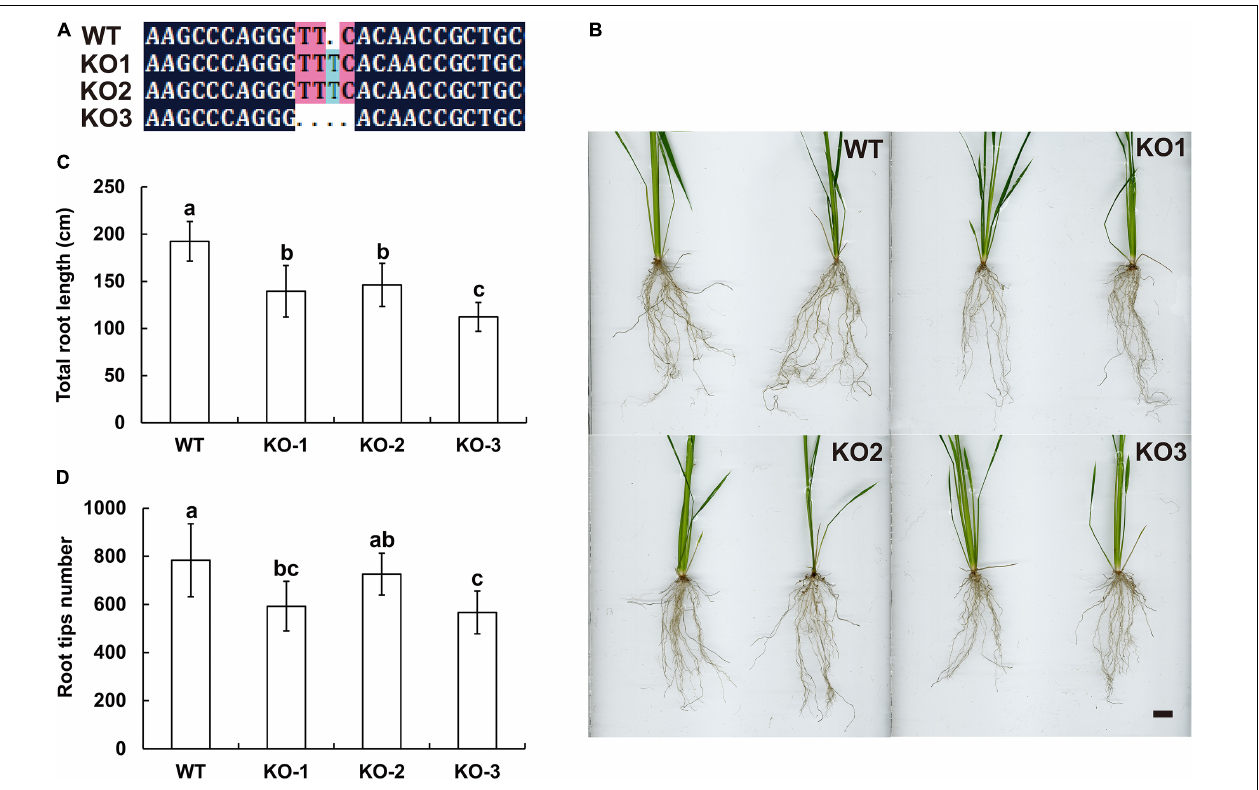
FIGURE 6 | Knocking out LOC_Os07g46560 ( EoSINAT5 homologous gene) in “Nipponbare” rice. (A) Sequencing analyses of LOC_Os07g46560 knockout homozygous lines. (B) Root phenotypes of WT and LOC_Os07g46560 knockout homozygous lines. Scale bar represents 1 cm. (C) Total root length of WT and LOC_Os07g46560 knockout homozygous lines. (D) Root tip numbers of WT and LOC_Os07g46560 knockout homozygous lines. Letters above bars indicate significant differences between the respective values ( p < 0 .